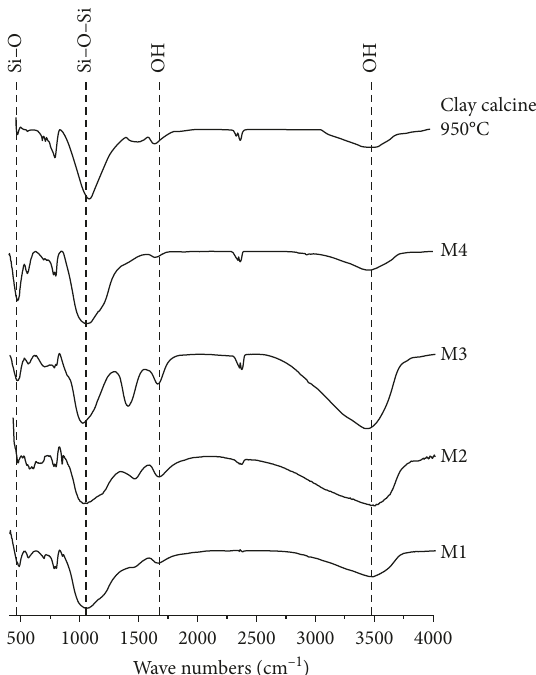
Figure 5: Fourier transform infrared (FTIR) spectra of the geo- polymer cement prepared with various NaOH concentrations.